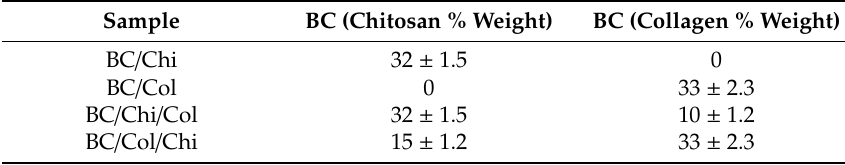
Figure 3. Illustration of ( a ) BC structure; ( b ) protonated chitosan structure; ( c ) protonated collagen structure; ( d ) BC-based wound dressing structure; and ( e ) BC-based wound dressing. Table 1. The weight percentage of impregnated